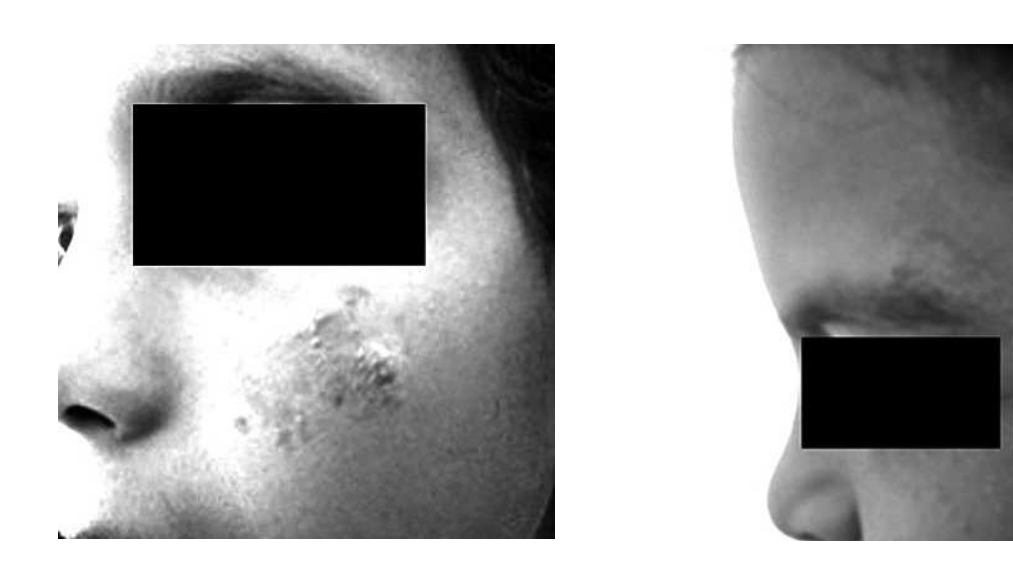
Fig. 4. – Satellite lesions at the periphery of the scar (Focus of Metlaoui).